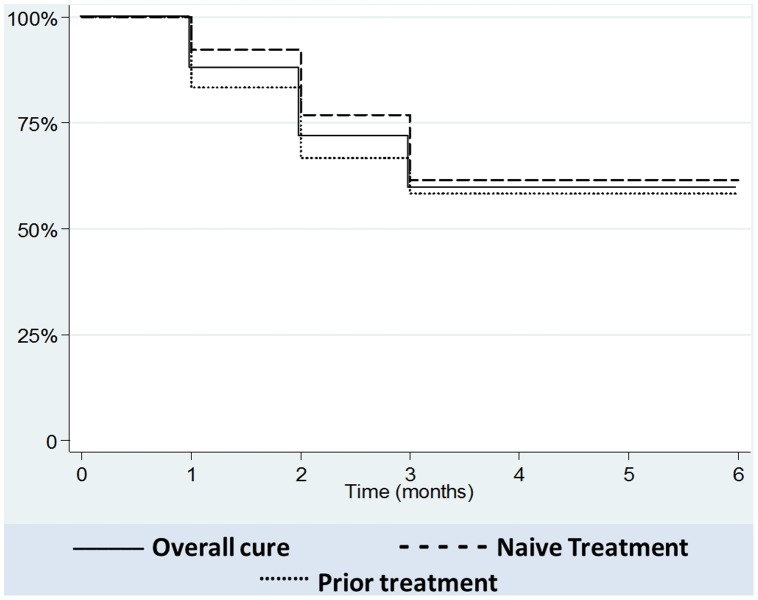
Kaplan-Meier curves.